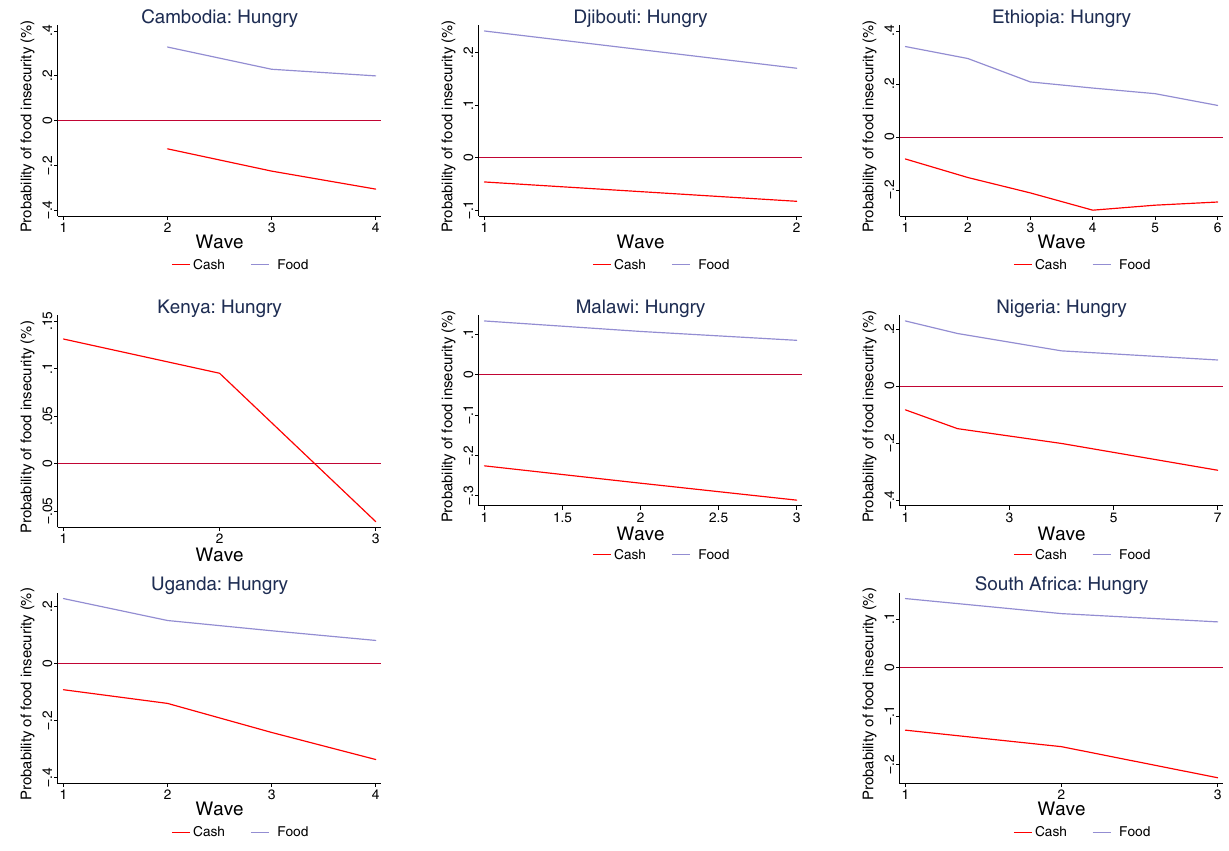
Figure 8. Impact of safety nets on food insecurity (went hungry) by